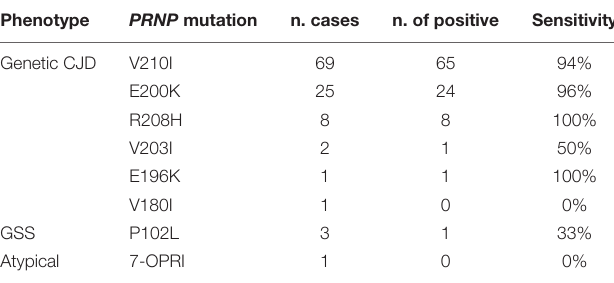
TABLE 7 | CSF RT-QuIC sensitivity in the ISS cohort of genetic prion